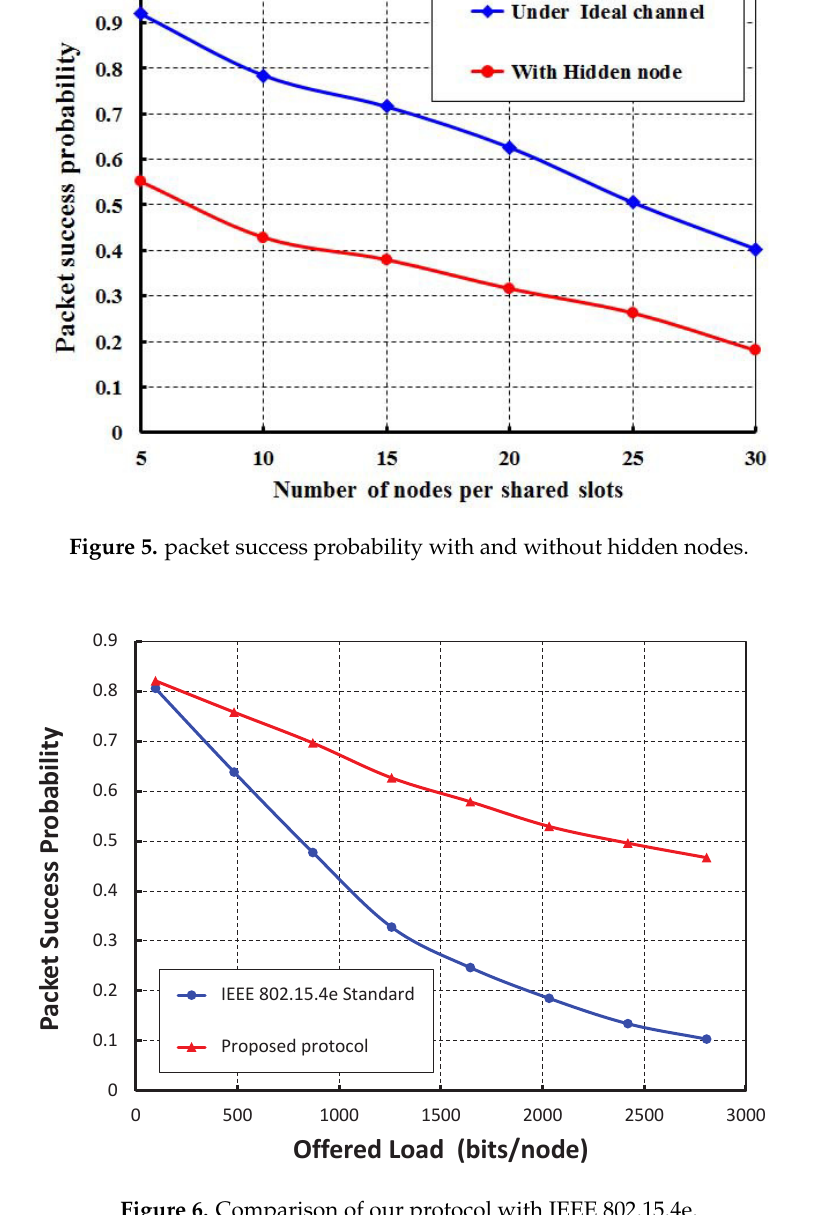
Figure 6. Comparison of our protocol with IEEE